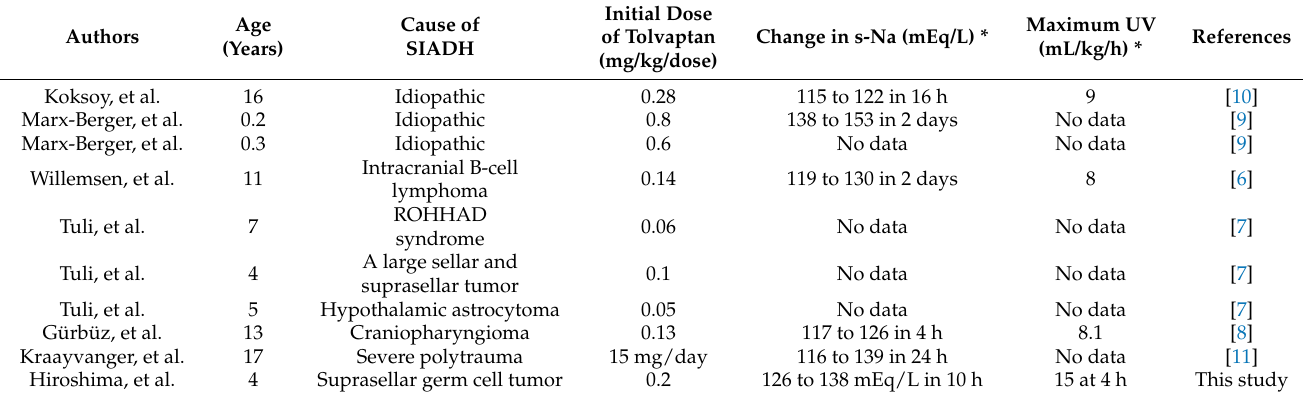
Table 2. Reported pediatric patients that were administered tolvaptan for